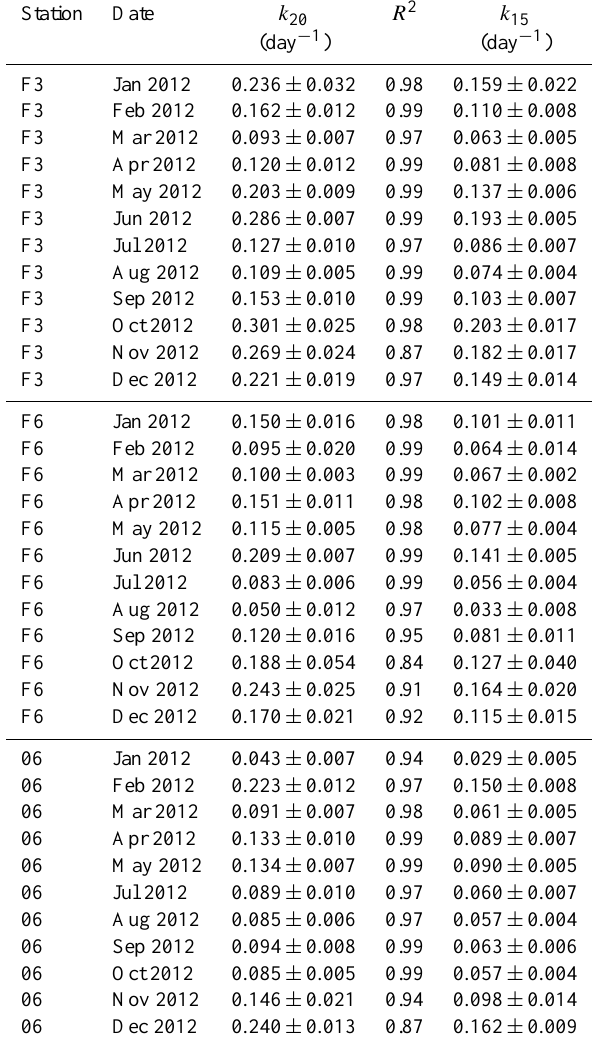
Table 3. Degradation constants for DOC ( k 20 ) and normalized degradation constants at 15 ◦ C ( k 15 ) ± standard deviation in Tokyo Bay (stations F3, F6, and 06). R 2 indicates coefficient of determi- nation.